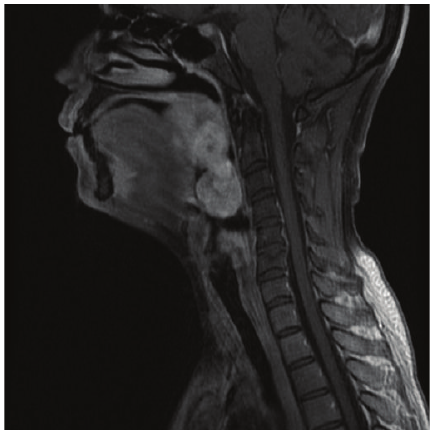
Figure 2: Magnetic resonance imaging of the head and neck assessing the deep extension of the tongue mass.